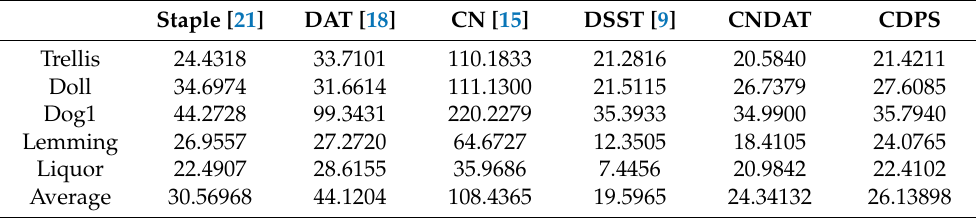
Table 5. Average speeds (frame per second) of the different tracking